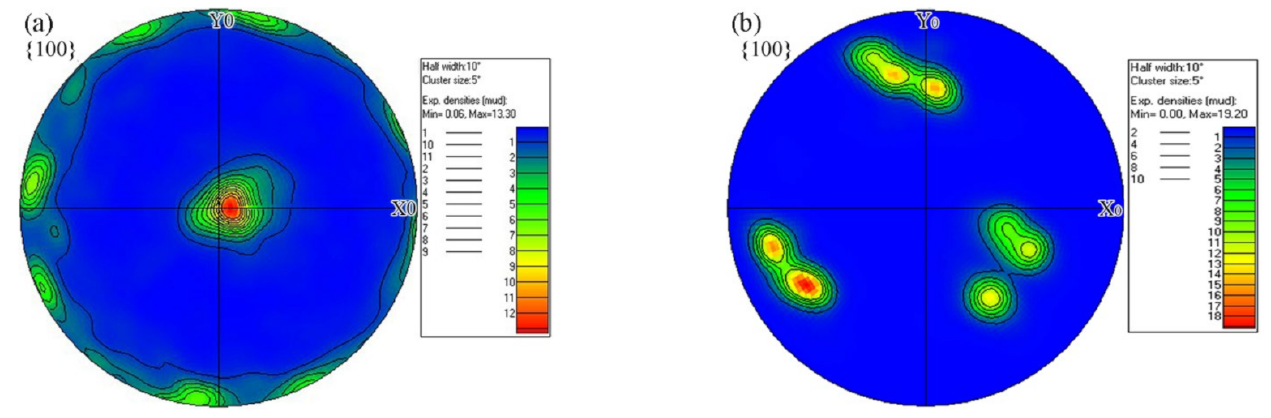
Figure 10. ( a ) Base metal and ( b ) fusion zone pole figures of the {001}